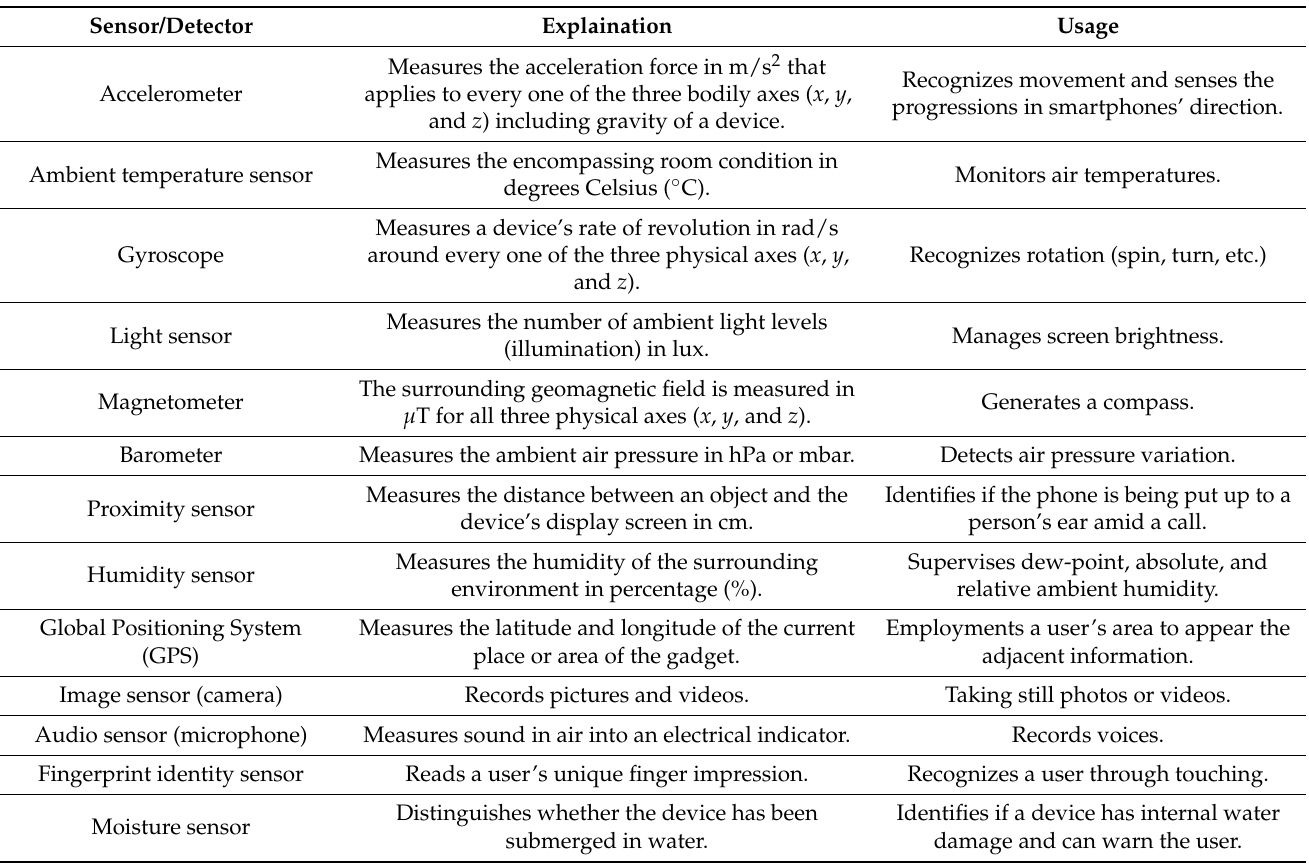
Table 1. Familiar smartphone sensors. Reprinted from ref.